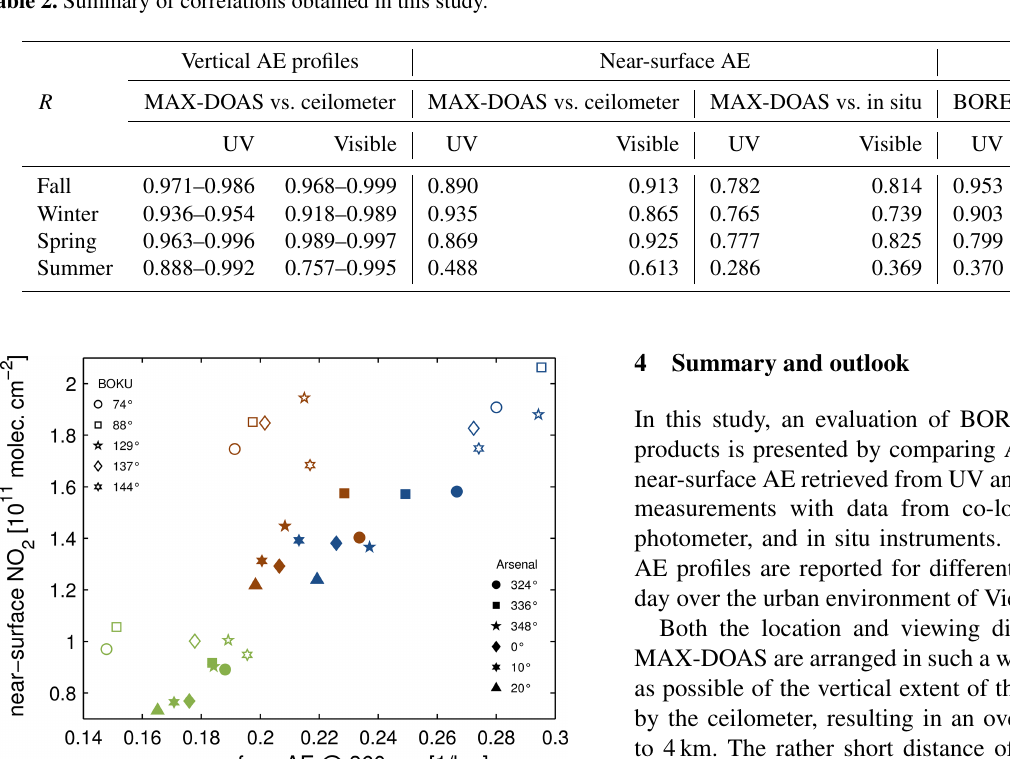
Table 2. Summary of correlations obtained in this study.